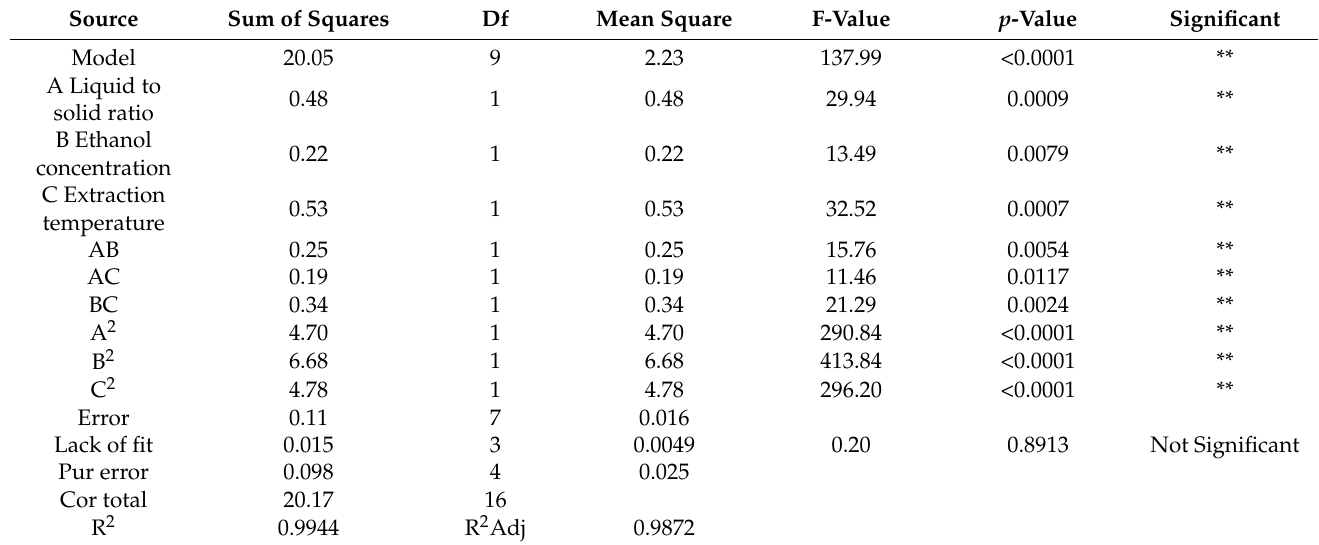
Table 6. Analysis of variance (ANOVA) for the experimental results obtained by Box–Behken response surface